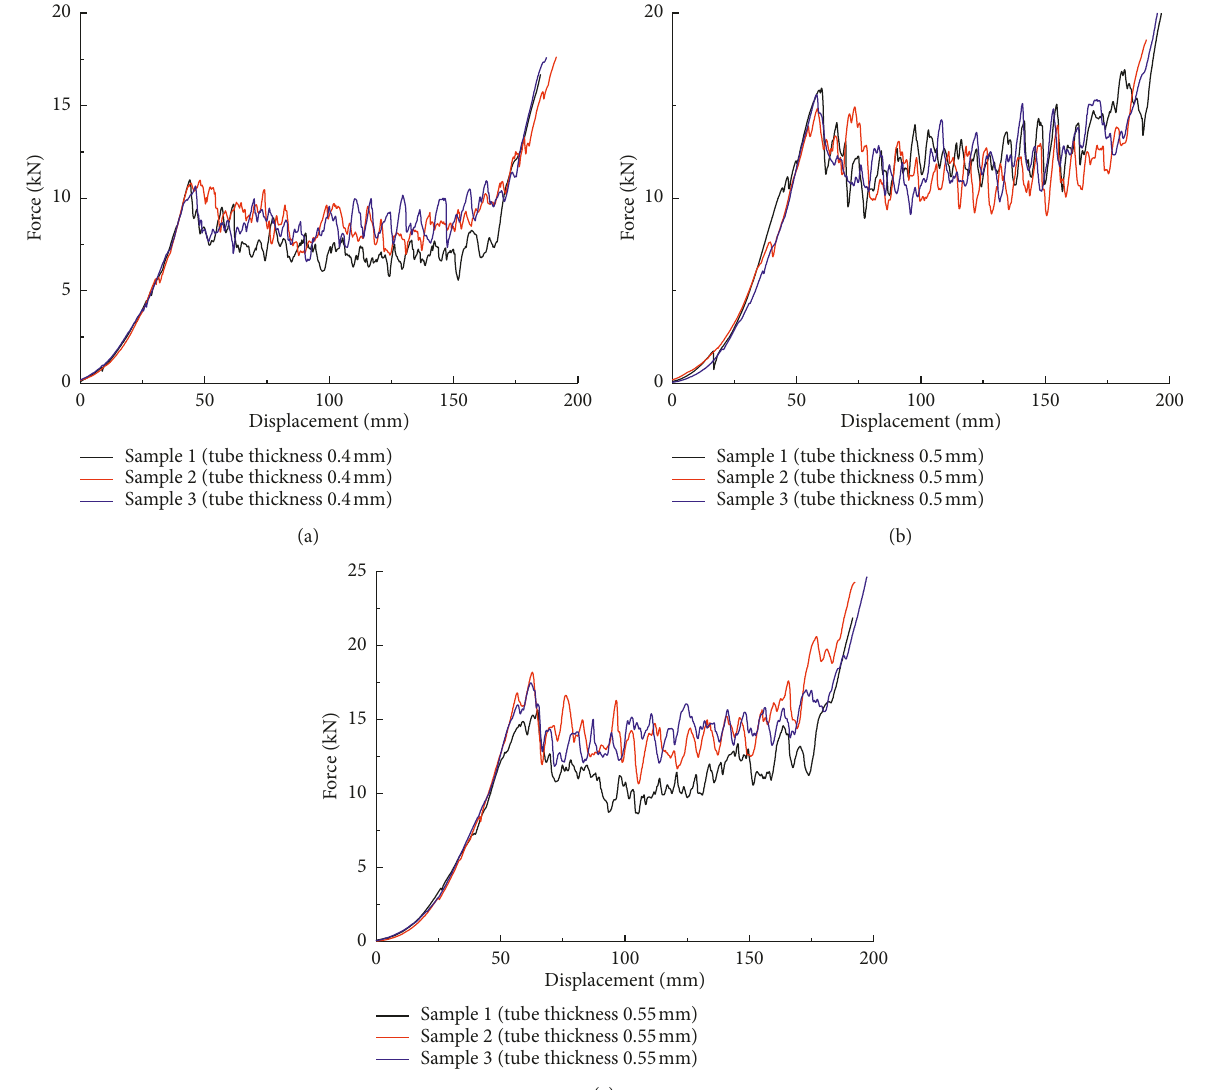
Figure 9: Quasistatic tensile load-displacement curves of the tube-crushing dissipators with different tube thicknesses: (a) 0.4mm, (b) 0.5 mm, and (c)